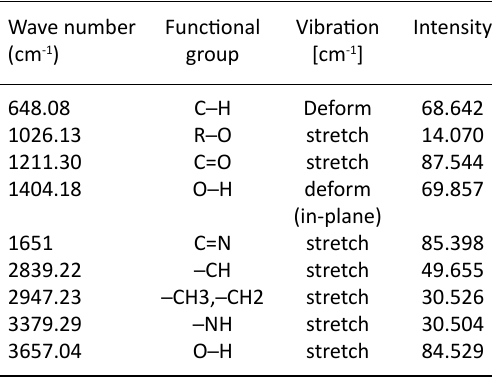
salicifolia crude extract. Absorption bands at 3370 cm -1 are due to the stretching of aromatic and aliphatic OH groups, whereas peaks in the range 1400-1651 cm -1 are assigned to stretching of aromatic rings. On the other hand, the two peaks at 2839 and 2947 cm -1 are ascribed to the =CH group, and the band at 1211 cm -1 confirms the in-plane binding of OH group in the plant crude extract. In the FTIR spectra of Au/AgNPs, the peak for in-plane OH group bending is